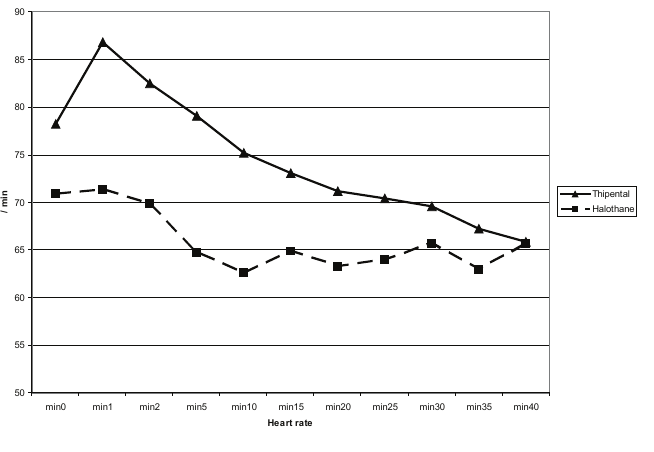
FIGURE 2 - Heart rate after the administration of thiopental and halothane.